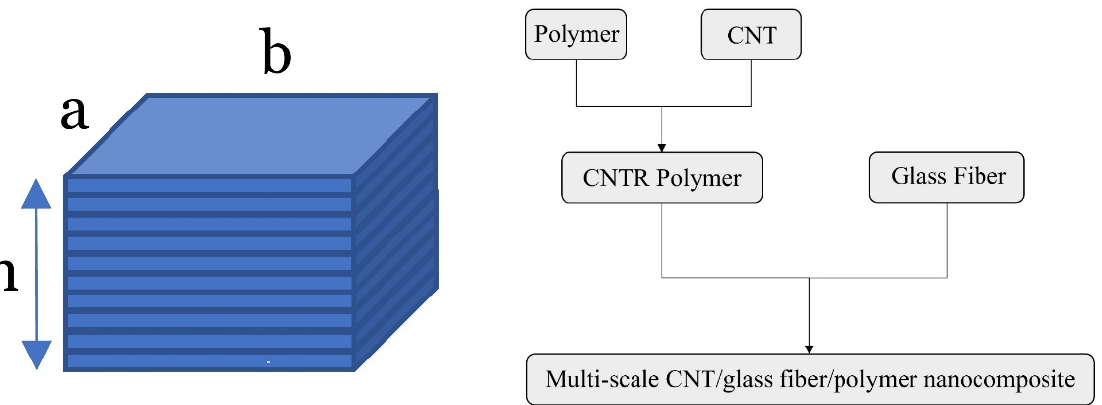
Figure 1. Schematic view of the analyzed multi-layered plate ( left figure) and the order by which the ingredients must be combined to manufacture a single ply of hybrid nanocomposite material ( right figure).